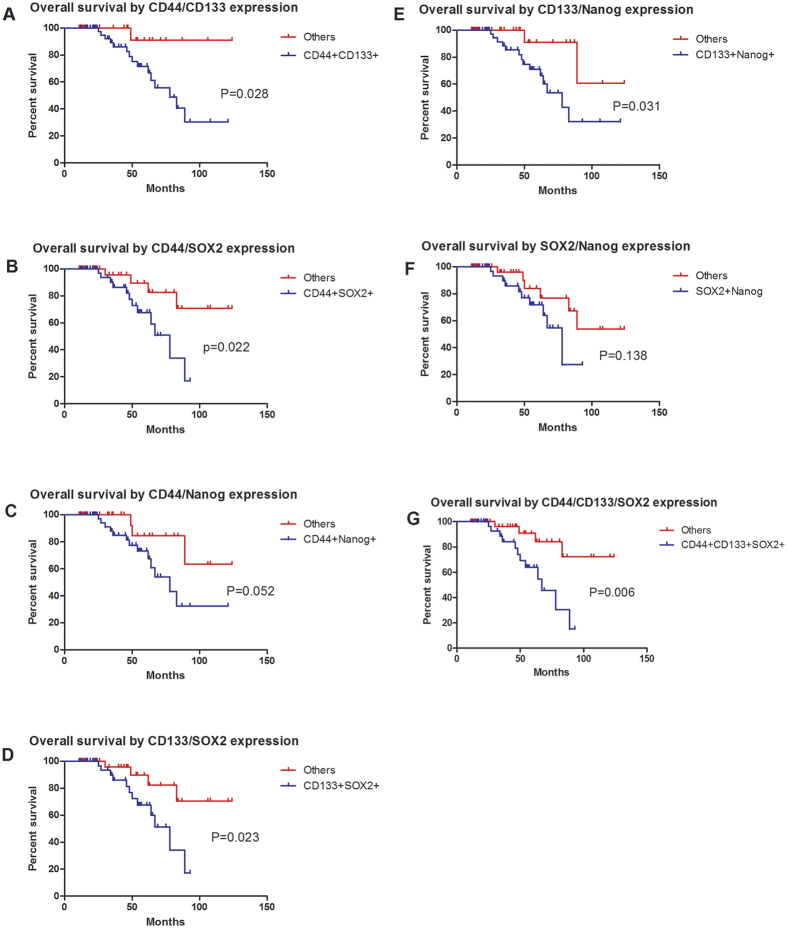
Kaplan–Meier curves estimated by various combination of markers, CD44/CD133 (A), CD44/SOX2 (B), CD44/Nanog (C), CD133/SOX2 (D), CD133/Nanog (E), SOX2/Nanog (F), CD44/CD133/Nanog (G).